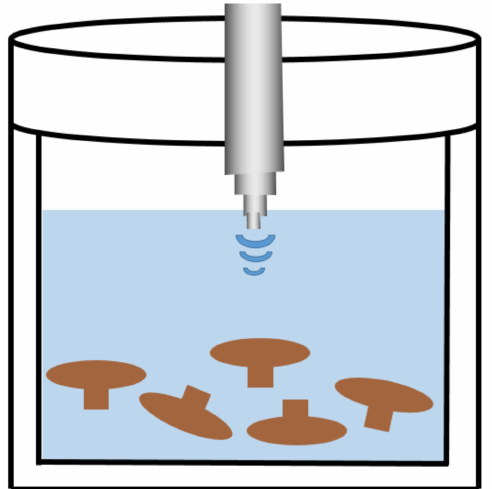
Figure 2. EFP extraction by